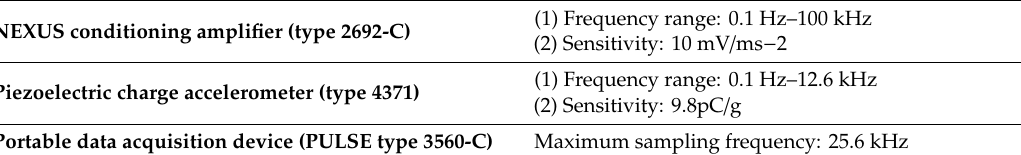
Figure 6. Single and combined bearing faults: ( a ) outer raceway crack (BCO), ( b ) inner raceway crack (BCI), ( c ) roller crack (BCR), ( d ) inner and outer raceway cracks (BCIO), ( e ) outer and roller cracks (BCOR), ( f ) inner and roller cracks (BCIR), and ( g ) inner-outer-roller cracks (BCIOR). Table 2. Specification of the data acquisition system.